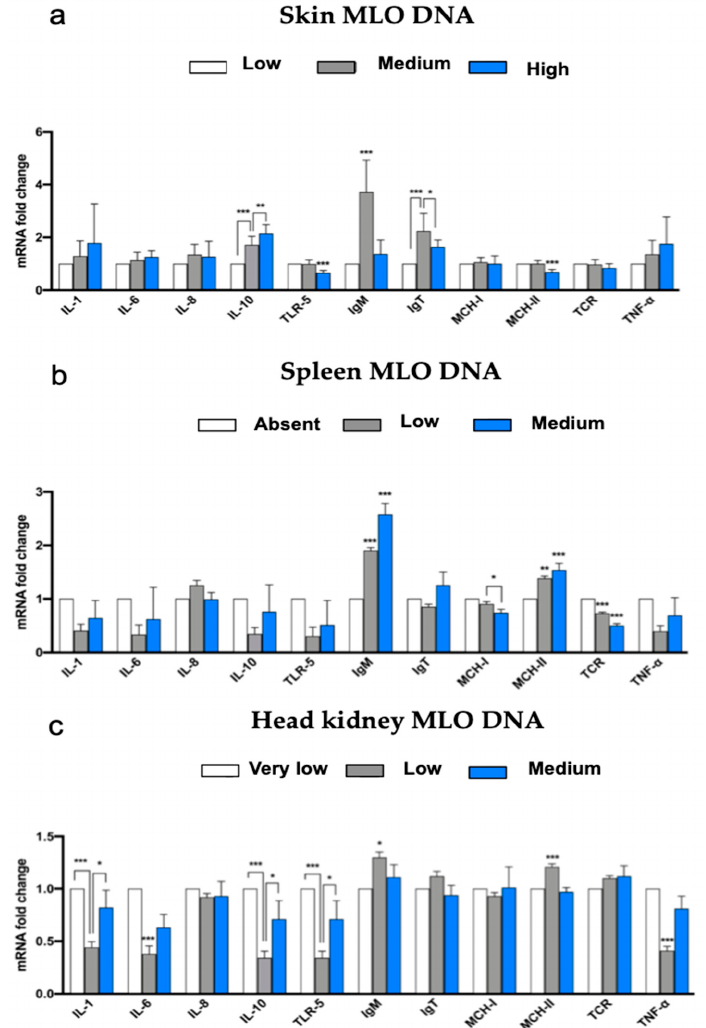
Figure 4. ( a – c ): Fold change ratio in relative RNA expression of immuno-related genes analyzed in the skin ( a ), spleen ( b ), and kidney ( c ) in relation to samples classified by their MLO DNA content. * = p < 0.1; ** = p < 0.05; *** = p < 0.01.